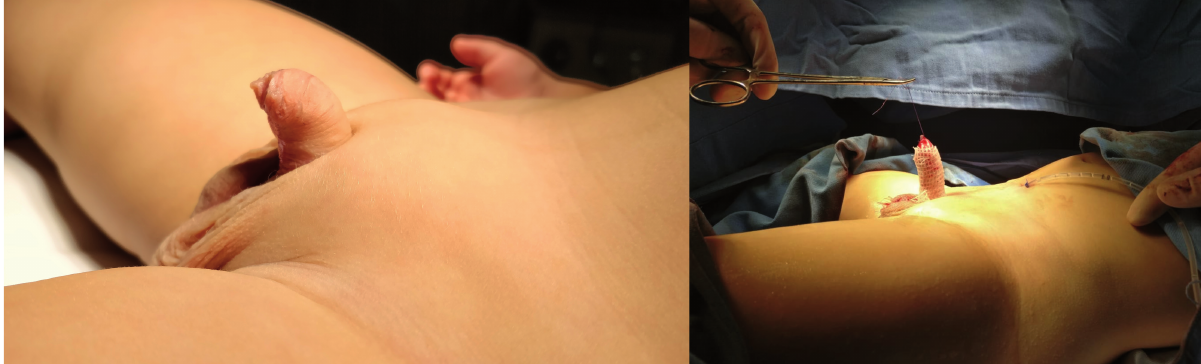
Supplementary Figure 1 - Before and after pubic lipectomy in patient with pubic hypertrophy. The abundant suprapubic fat mimics the mons pubic and it is hiding the penis for half of his